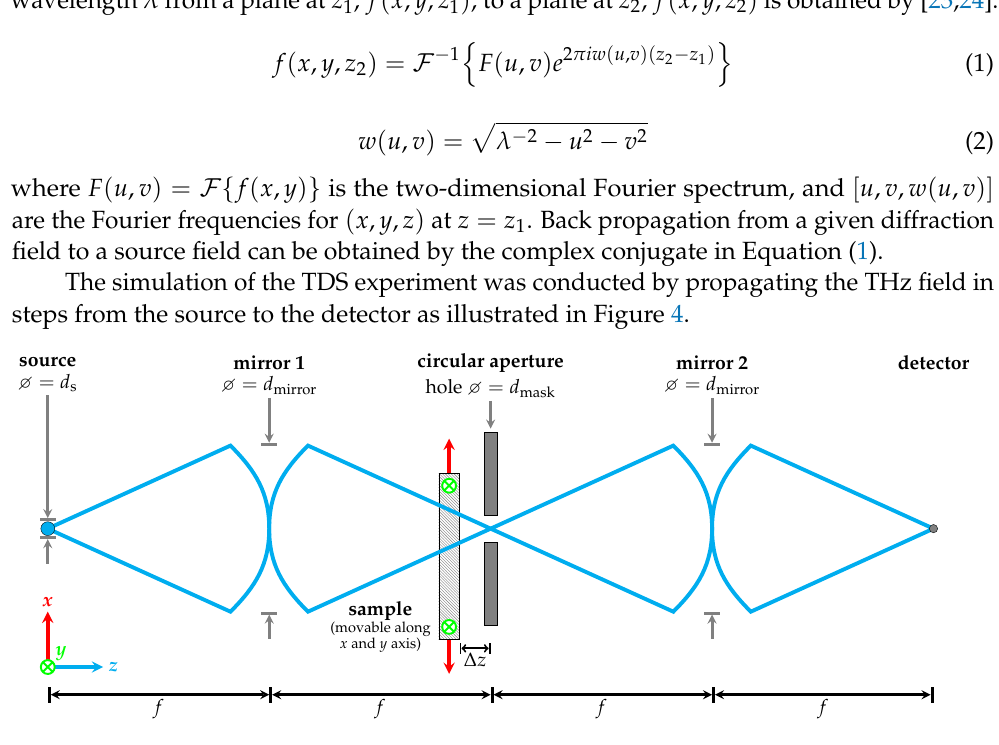
Figure 4. Simulation scheme of TDS experiments (not to